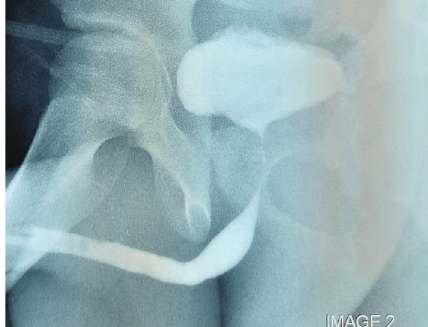
Figure 8: Suturing the right edge of the graft to the right aspect of the urethral plate over the size 16Fr catheter.